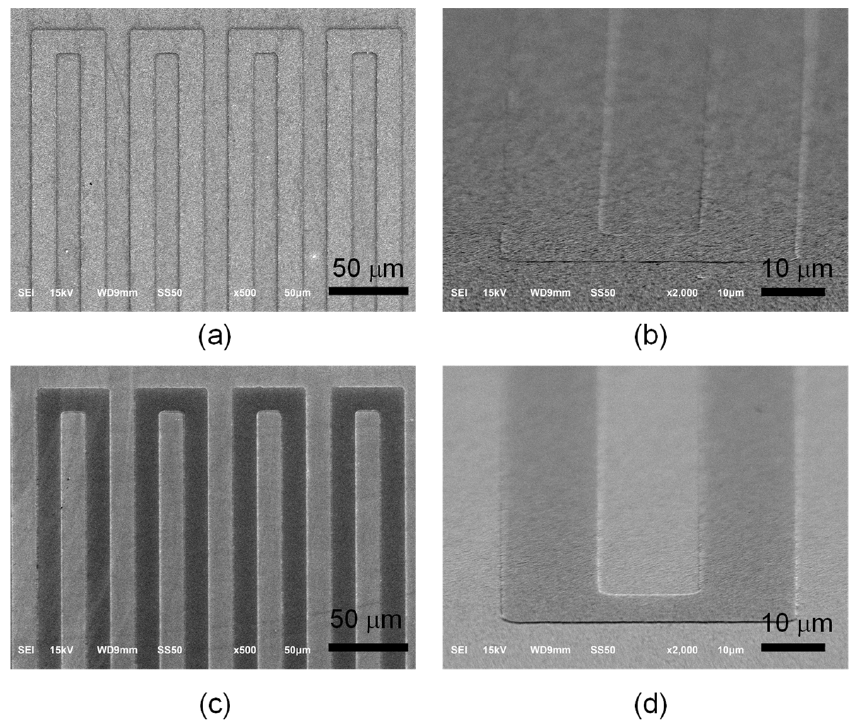
Figure 3. Scanning electron microscopy images of Pt ribbon deposited on a Pt layer at ( a ) 0 ◦ and ( b ) 45 ◦ incident angles. Scanning electron microscopy images of TiO 2 ribbon deposited on a TiO 2 compact layer at ( c ) 0 ◦ and ( d ) 45 ◦ incident angles.